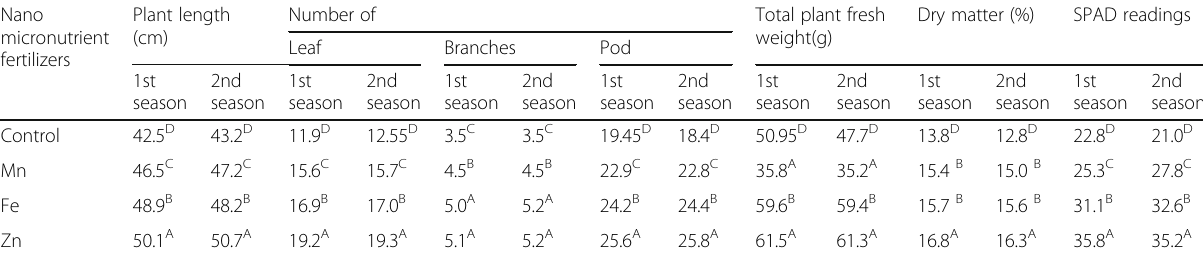
Table 3 Effect ofnano micronutrient fertilizerson vegetative growth of snap bean plants during 2017 and 2018 seasons Nano micronutrient fertilizers